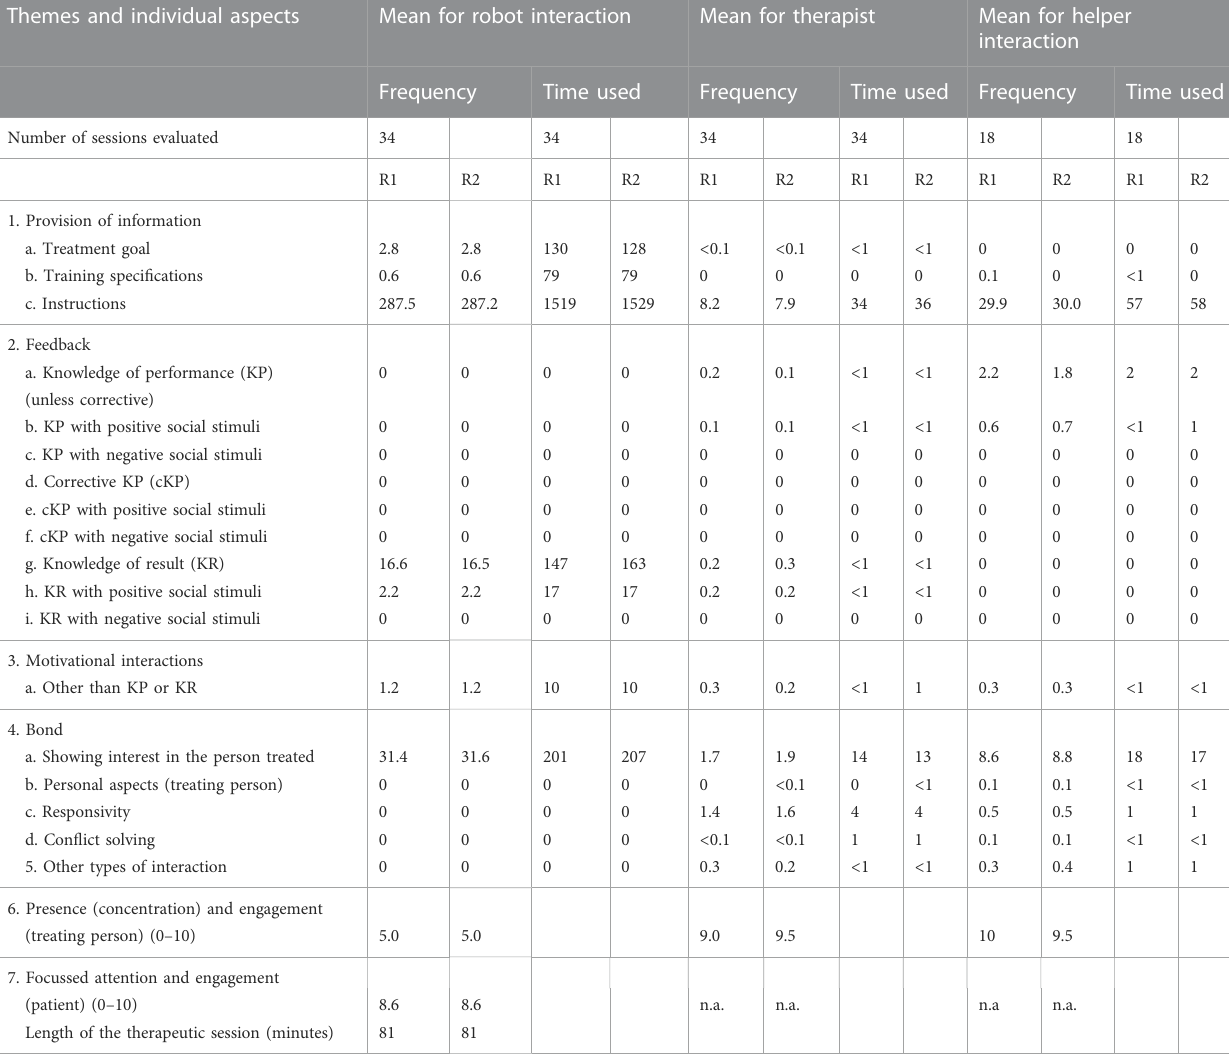
TABLE 2 THER-I-ACT observations: The observations (mean) for individual categories by a rater (17 participants; two sessions each). Themes and individual aspects